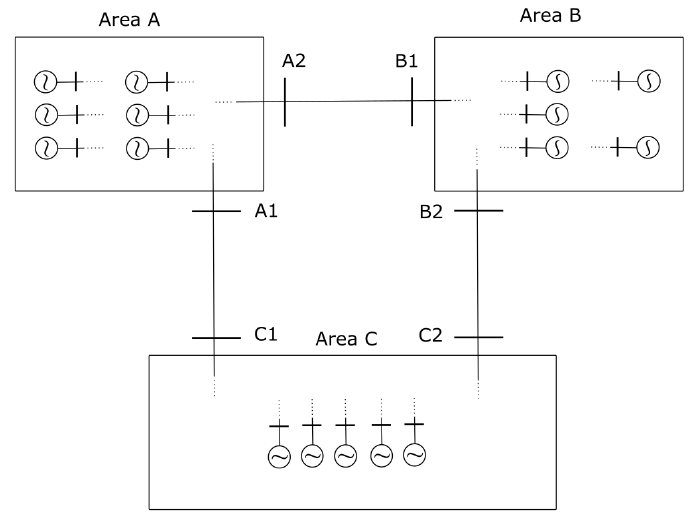
Figure 15. PST 16 Benchmark test